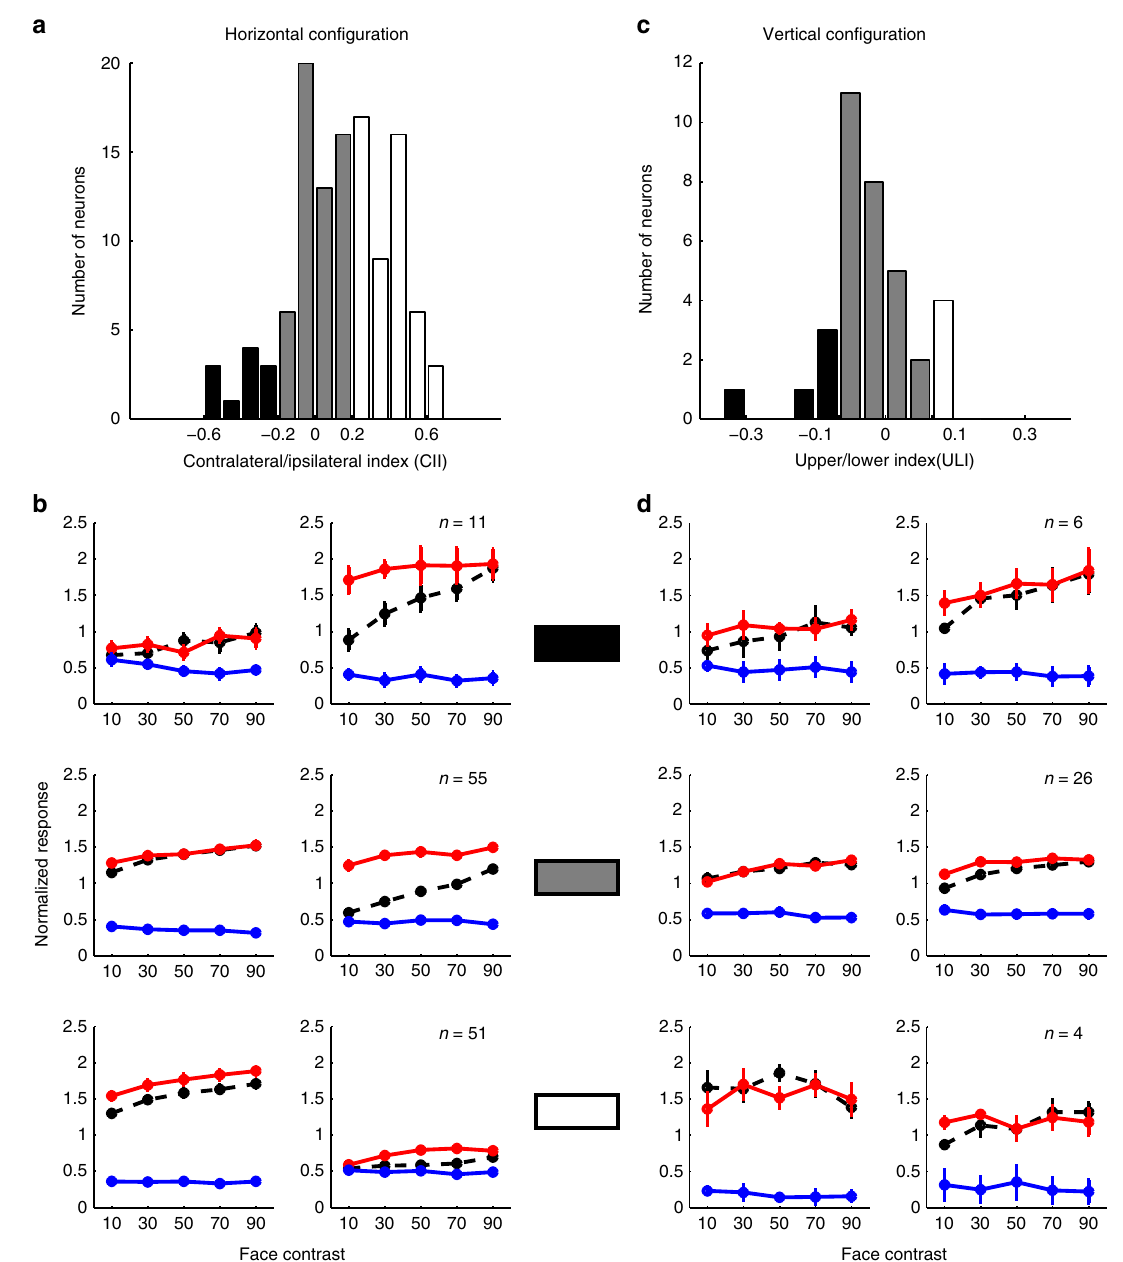
Fig. 3 The integration rule for face-object pairs does not depend on a neuron ’ s spatial tuning. a The distribution of preference for contralateral/ipsilateral across the population, de fi ned as CII (see Methods). Neurons were classi fi ed into three groups: (1) high preference for the ipsilateral visual fi eld (CII < − 0.2, black), (2) low preference or no preference (|CII| ≤ 0.2, gray), (3) high preference for the contralateral visual fi eld (CII > 0.2, white). b The